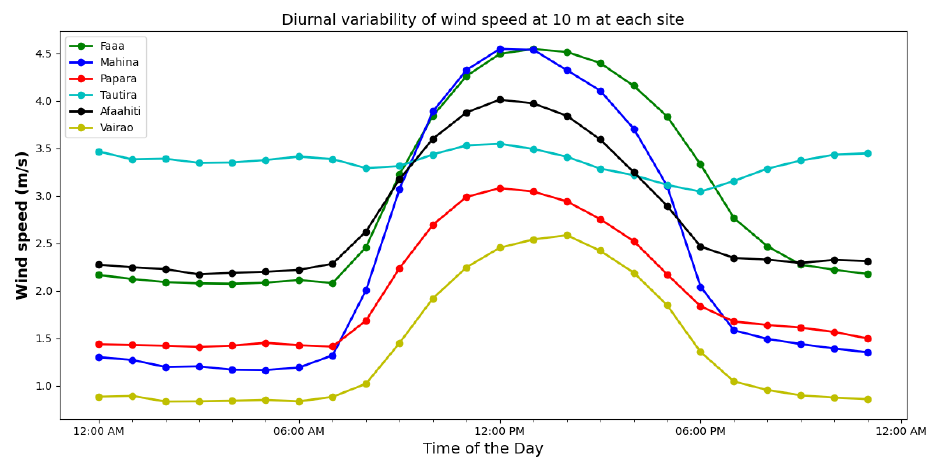
Figure 4. Hourly wind